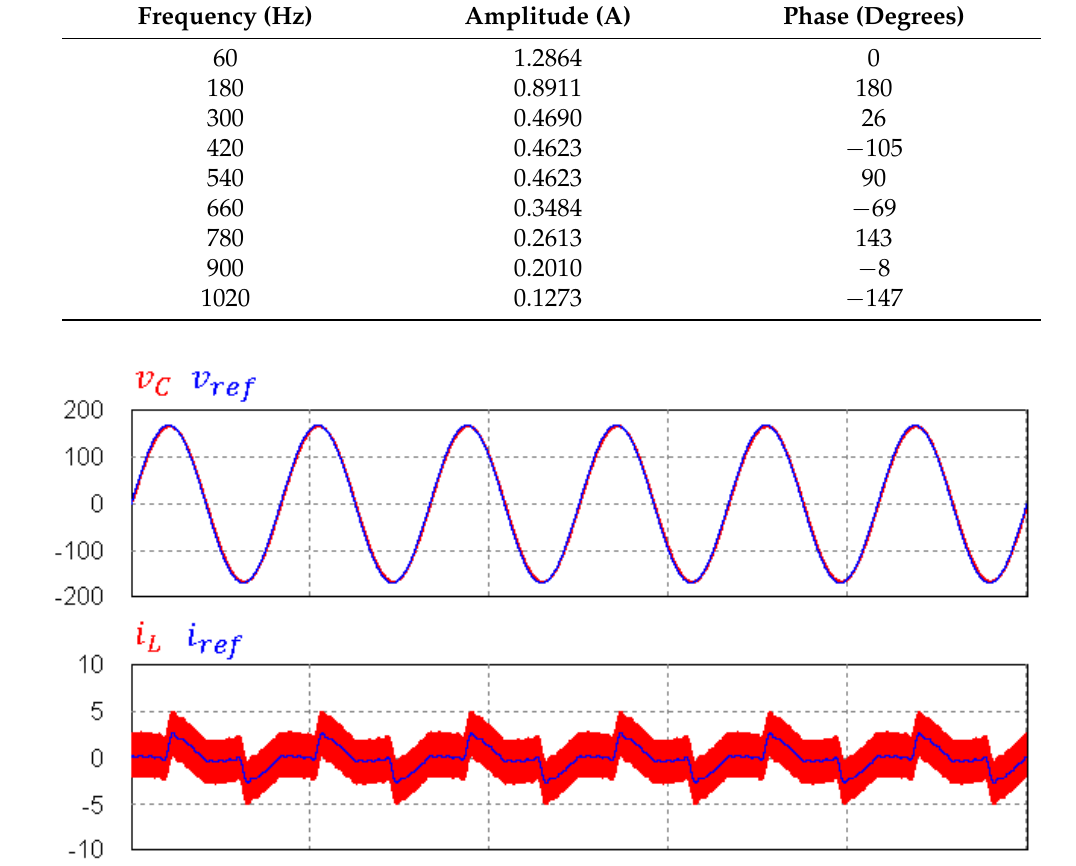
Table 2. Parameters of the TBR-type nonlinear load.